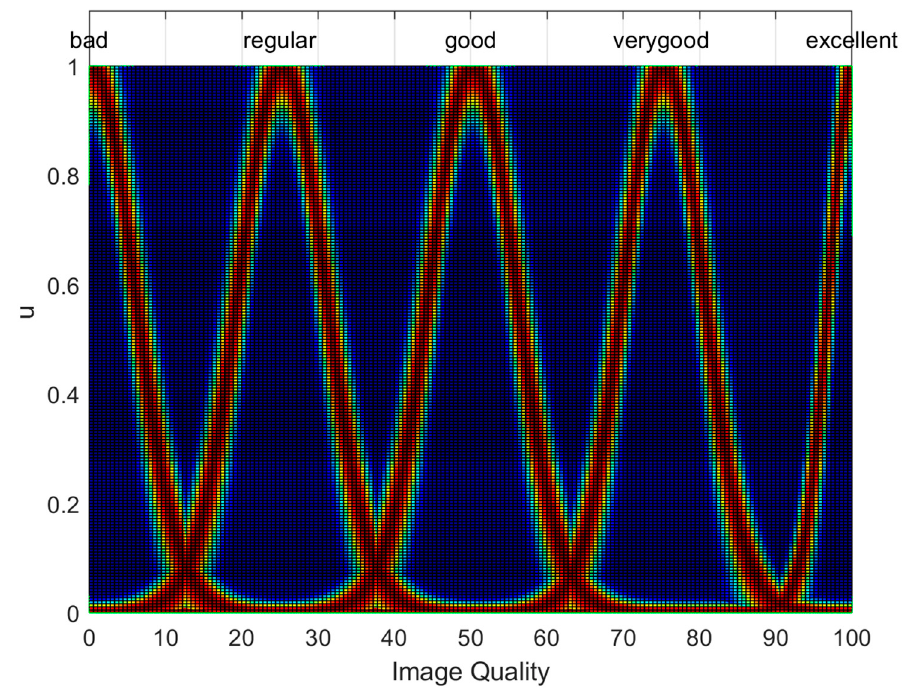
Figure 11. Output MFs of the image quality variable.